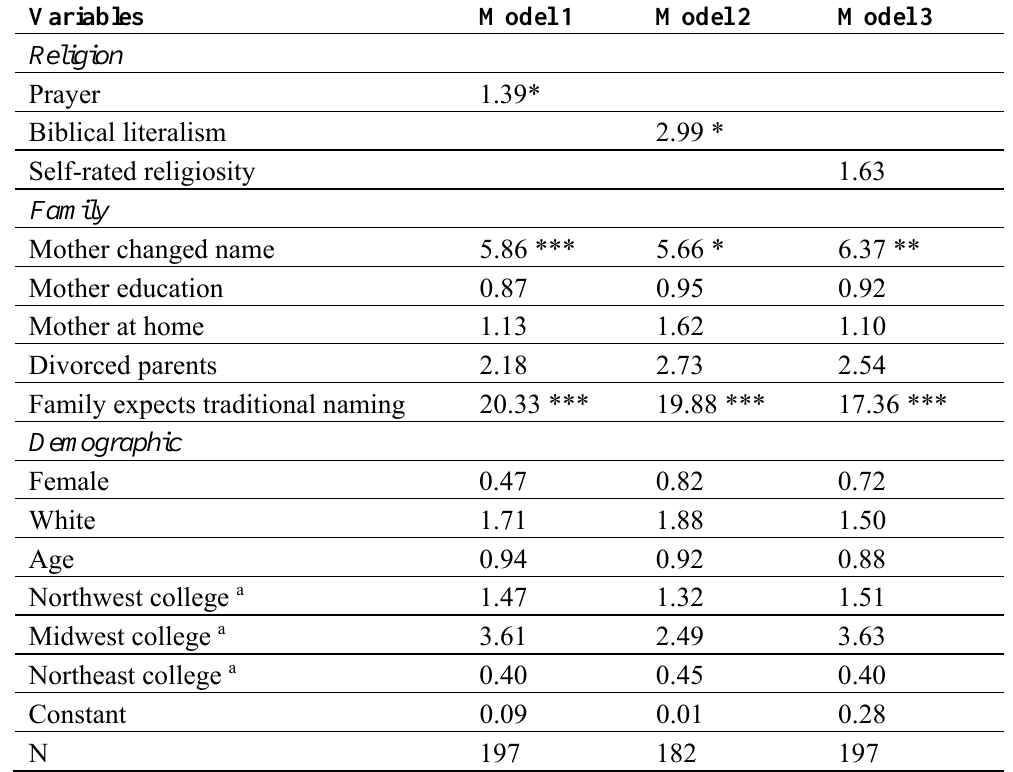
Table 3. Religious, Family, and Demographic Influences on Plans to Follow Traditional Marital Naming